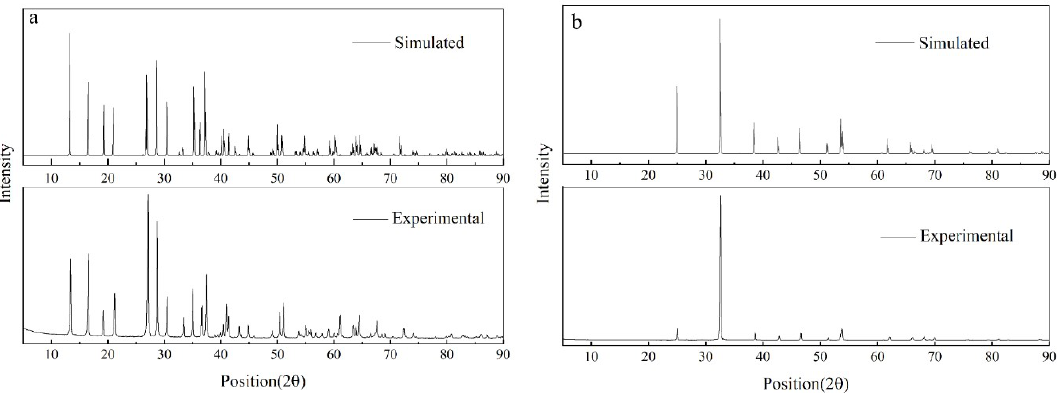
Figure 3. XRD pattern of hemimorphite ( a ) and smithsonite ( b ) by simulated and experimental methods.